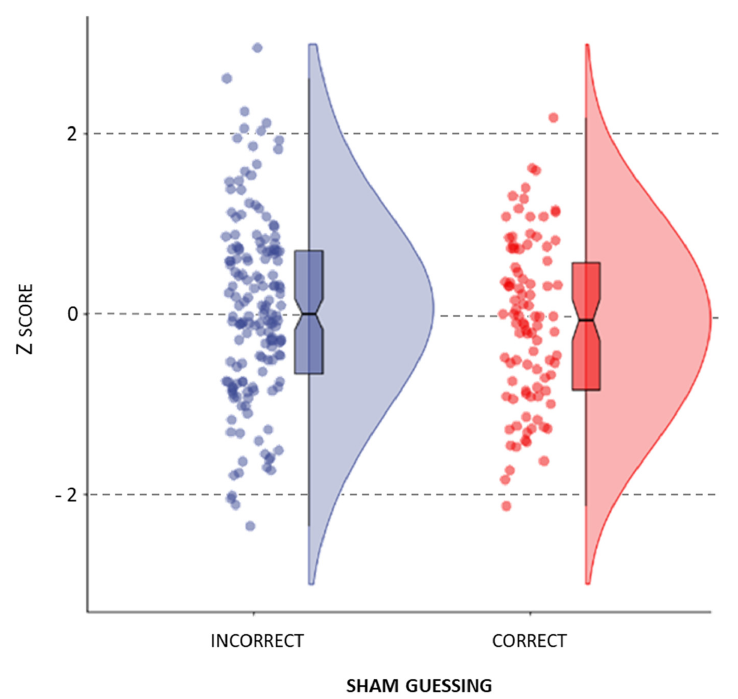
Figure 3. The effect of sham guessing on the standardized anode–sham difference across all obser- vations.